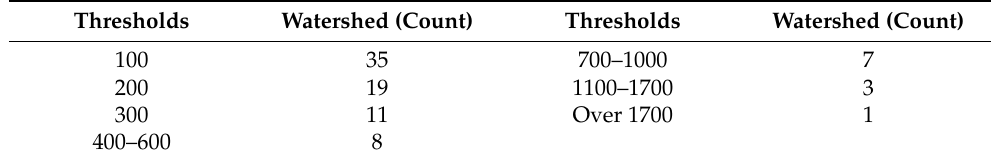
Table 6. Number of watersheds by thresholds.